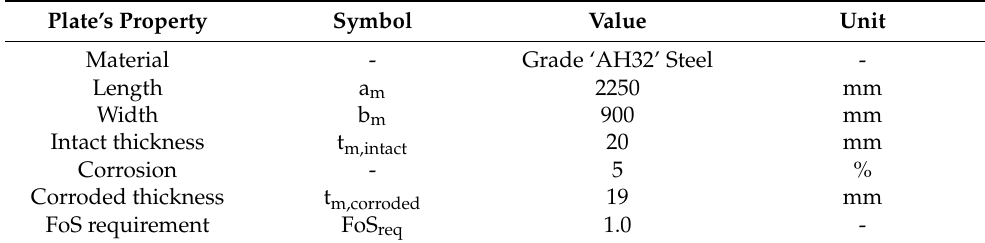
Table 2. Metallic damaged plate’s